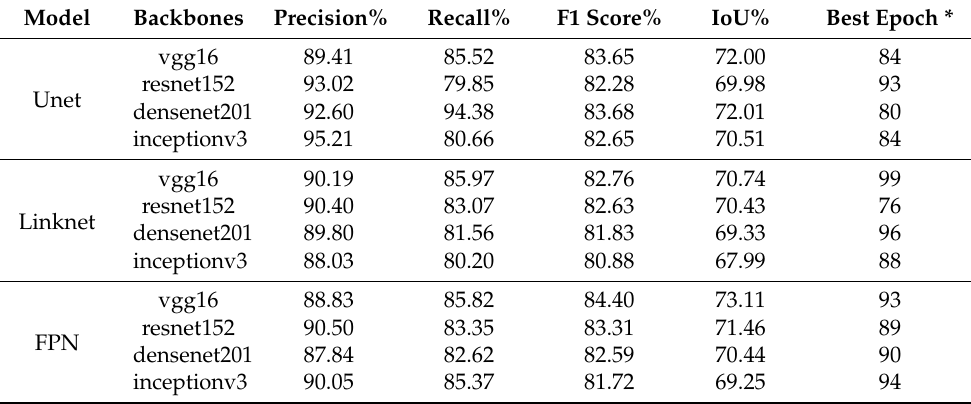
Table 4. The metrics are presented for the validation